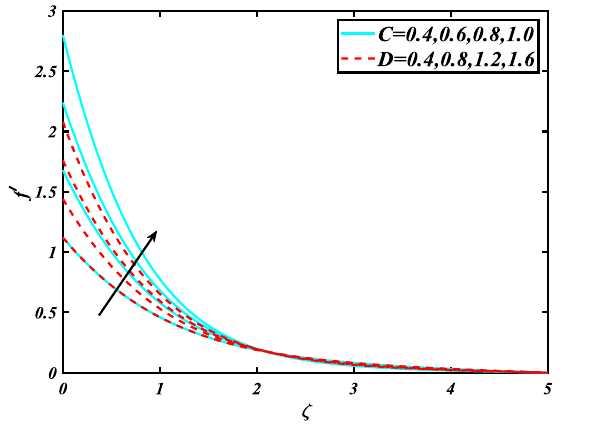
Figure 2. Significance of C & D for f ′ .